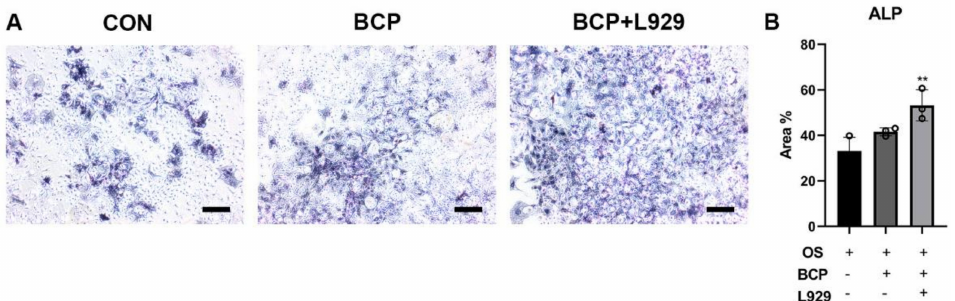
Figure 9. BCP ceramics promoted BMSCs osteogenic differentiation through fibroblasts. ( A ) Repre- sentative images and ( B ) semi-quantitative results of ALP staining of BMSCs after 7-day induction showed BMSCs cultured with conditioned media from L929 and BCP were more likely to differentiate into osteoblasts. Scale bar: 100 µ m. ** indicated p <